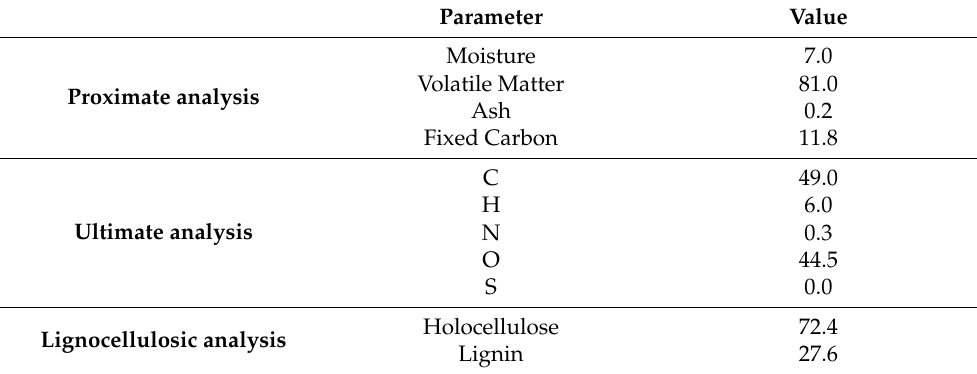
Table 1. The result of analysis of Phyllostachys edulis